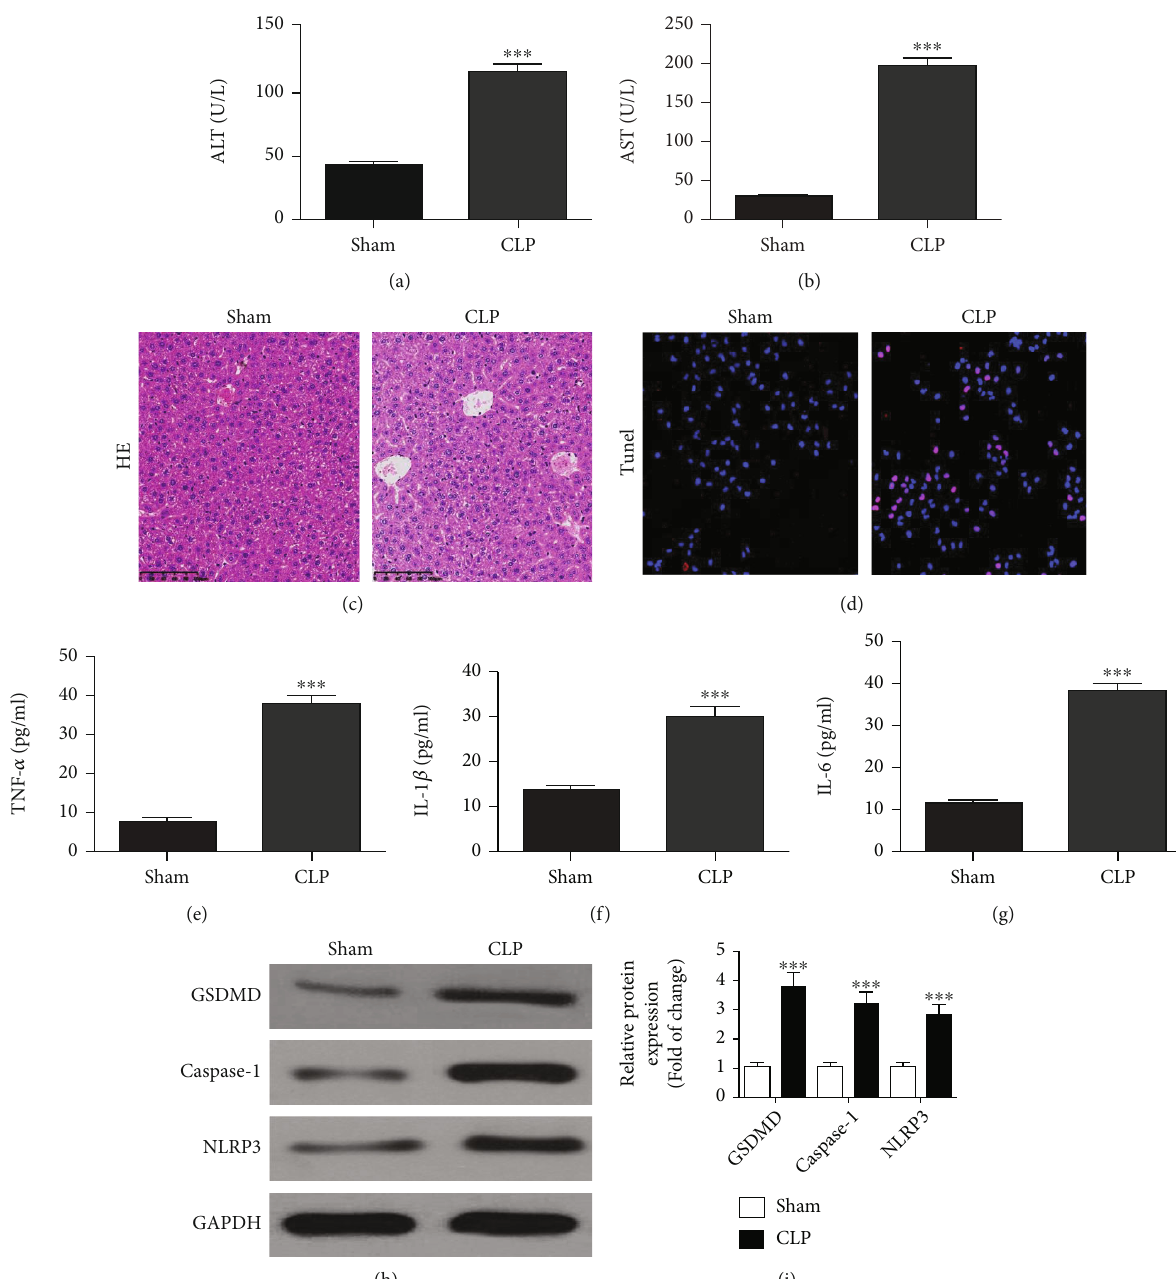
Figure 1: CLP-induced sepsis promoted liver injury by increasing in fl ammatory pyroptosis. Mice were sacri fi ced 12h after CLP, and liver tissues and serum were collected for further analysis. (a, b) ALT and AST expression levels were measured using ELISA. Data were presented as mean ± SD . ∗∗∗ P < 0 : 001 , versus the sham group. (c, d) HE and TUNEL staining showed the liver injury (magni fi cation, × 200). (e) – (g) ELISA detection showed the expression of in fl ammatory factors TNF- α , IL-1 β , and IL-6. Data were presented as mean ± SD . ∗∗∗ P < 0 : 001 , versus the sham group. (h, i) Western blot detection showed GSDMD, caspase-1, and NLRP3 expression. Data were presented as mean ± SD . ∗∗∗ P < 0 : 001 , versus the sham